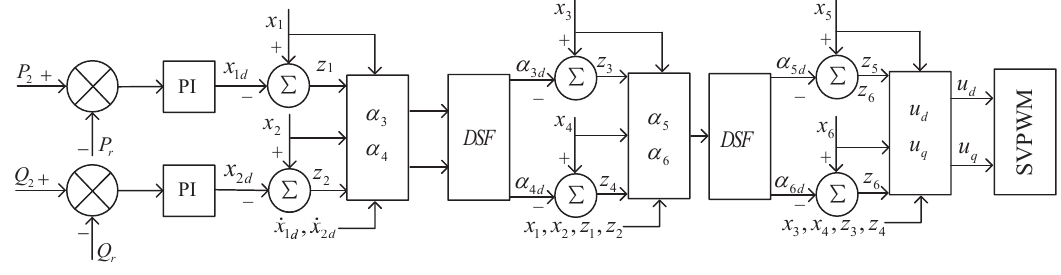
Figure 3. The control structure diagram in this paper.